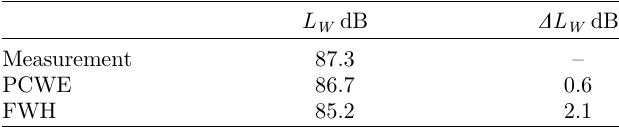
Table 6. Predicted sound power level from the FWH and PCWE methods compared with the measurement